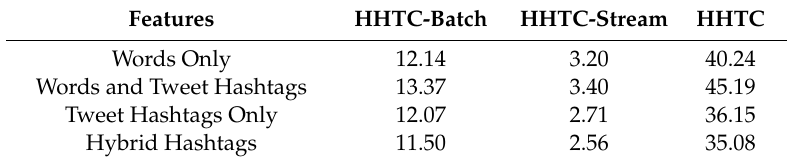
Table 7. Total execution time (in seconds) for both preprocessing and classification combined.